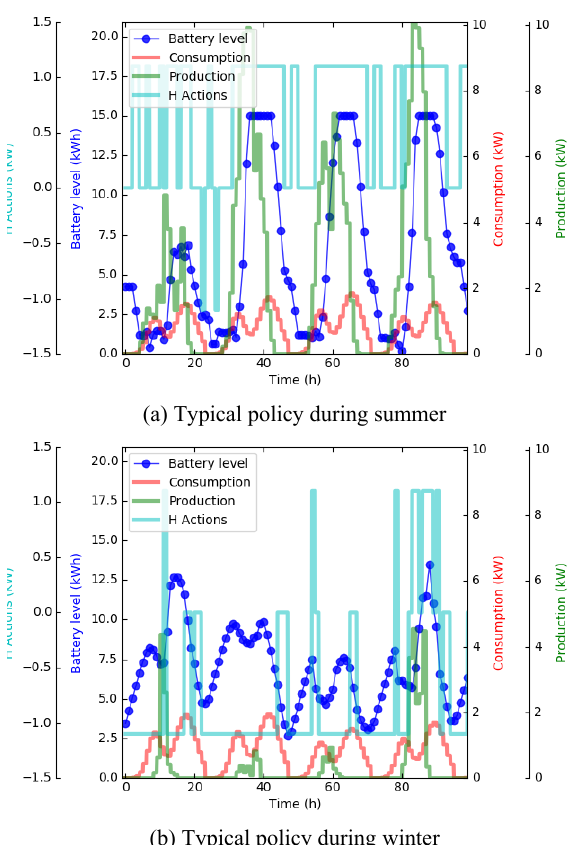
Fig. 11. Computed policy with minimal information available to the agent. H action = 0 means discharging the hydrogen reserve at maximum rate; H action = 1 means doing nothing with the hydrogen reserve; H action = 2 means building up the hydrogen reserve at maximum rate.